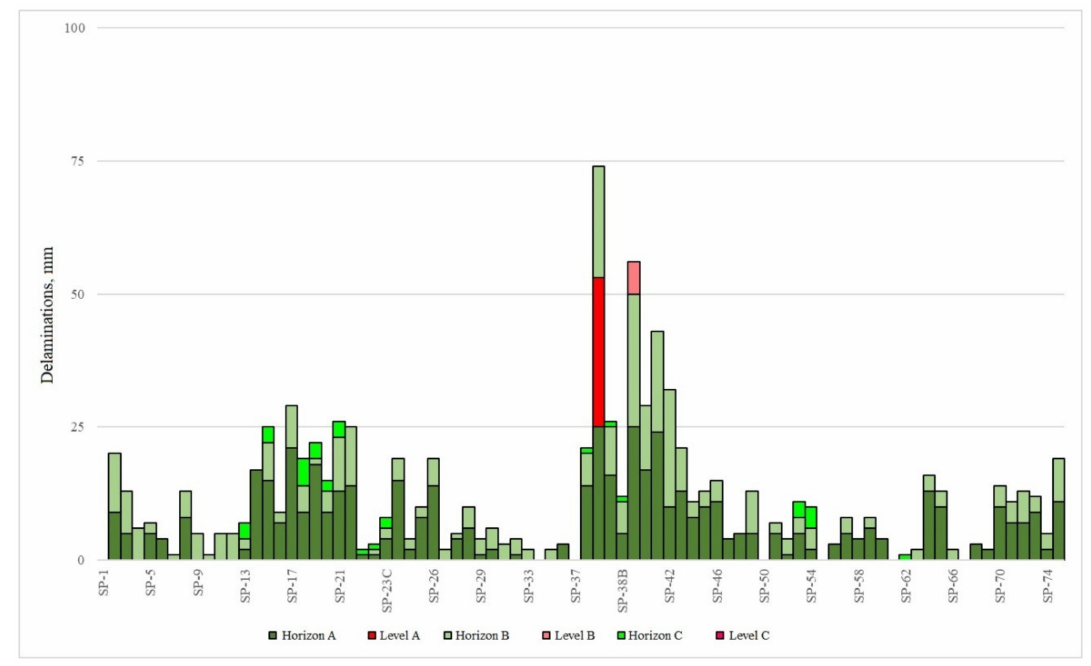
Figure 9. Values of the delaminations measured during everyday